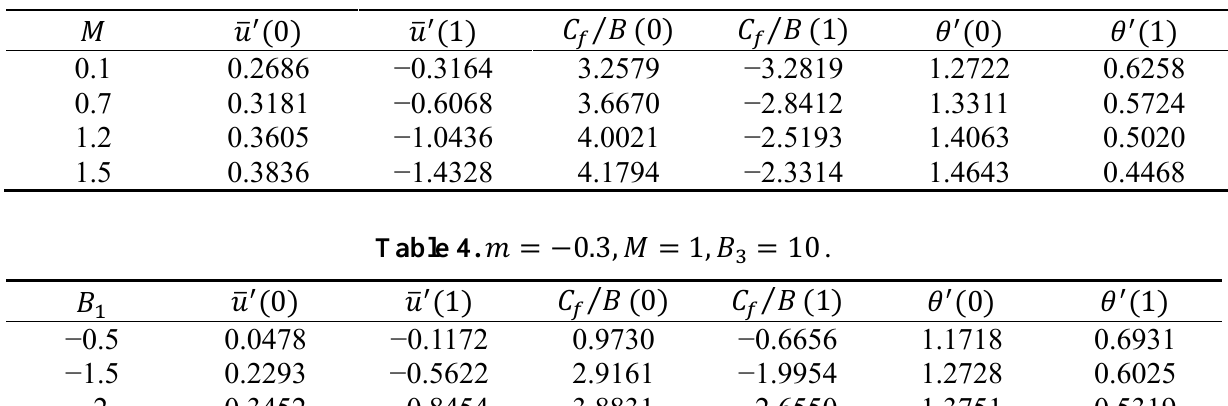
Table 3. 𝑚 = −0.3, 𝐵